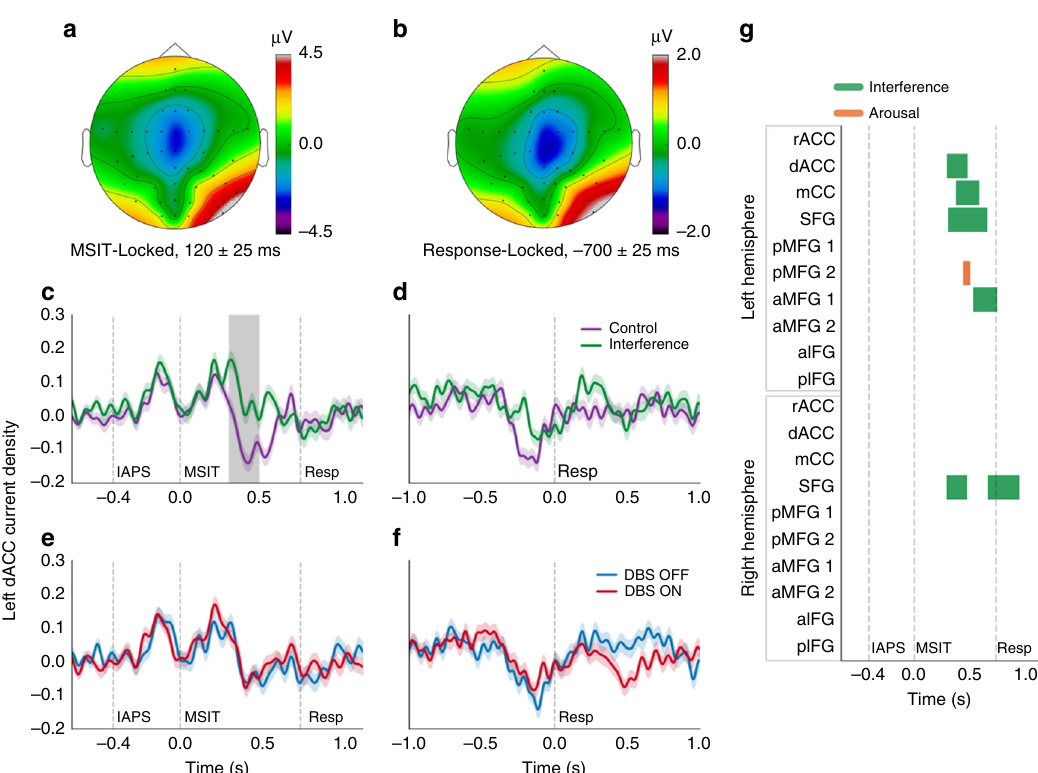
Fig. 4 Interference, but not deep brain stimulation (DBS), modulates time-domain evoked potentials (ERPs) in source space. a , b Grand mean topographic plots of a stimulus- and ( b ) response-locked ERP. Voltages in control and interference trials were normalized against their respective pre-trial baselines before averaging. c – f Source-localized time courses of current density attributable to the left dorsal anterior cingulate gyrus (dACC) label, shown locked either to MSIT presentation ( c , e ) or response ( d , f ), and for both the control/interference contrast ( c , d ) and DBS ON/OFF contrast ( e , f ). dACC is